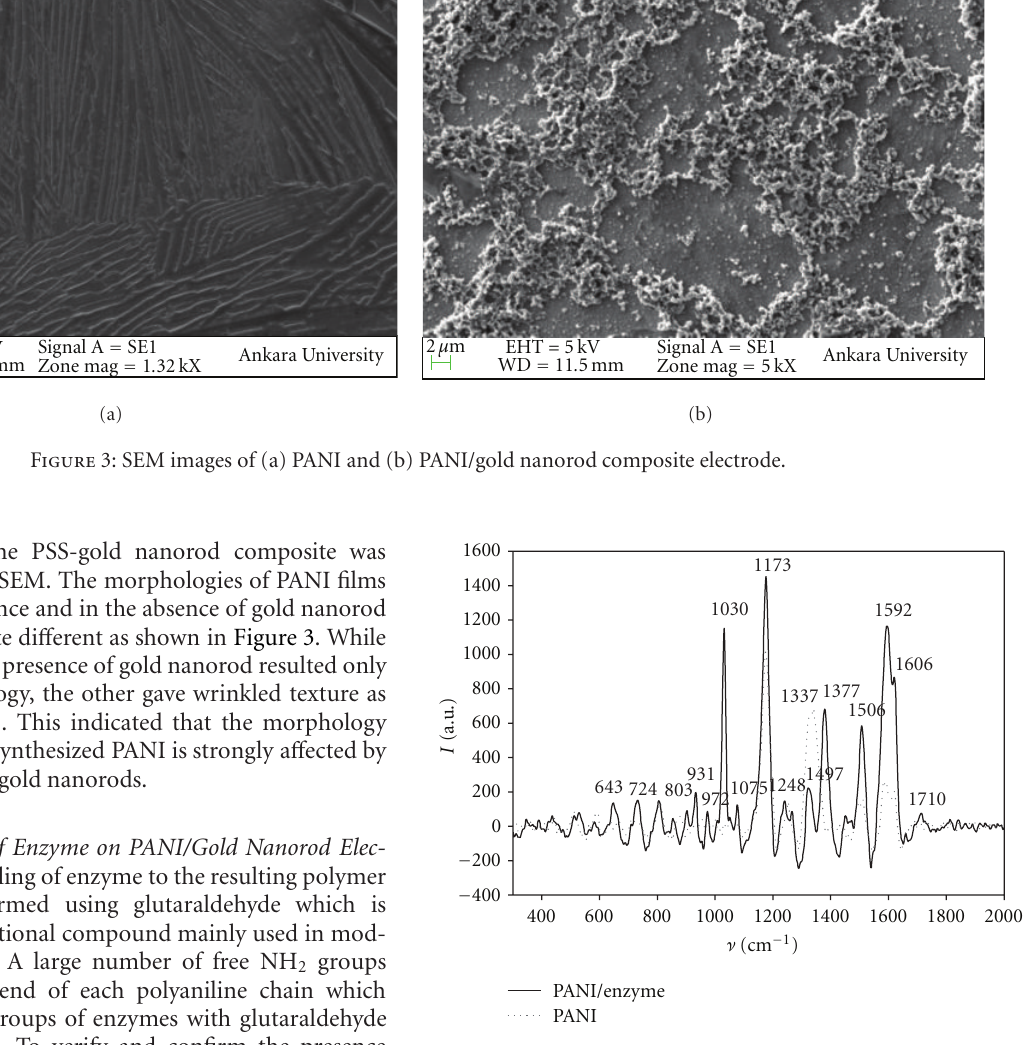
Figure 4: SERS spectrum within the range of 300–2000cm − 1 of PANI film doped with PSS-modified gold nanorod (dotted line) and after immobilization of glucose oxidase (solid